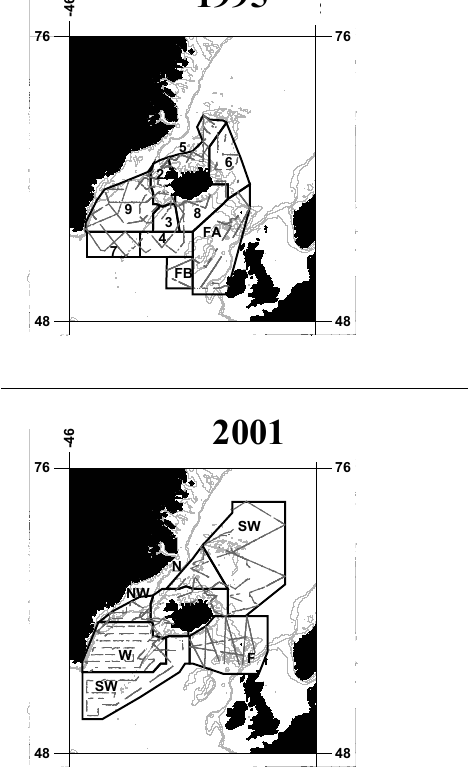
Fig. 2. Original block structure and realized search effort in NASS 1995 and NASS